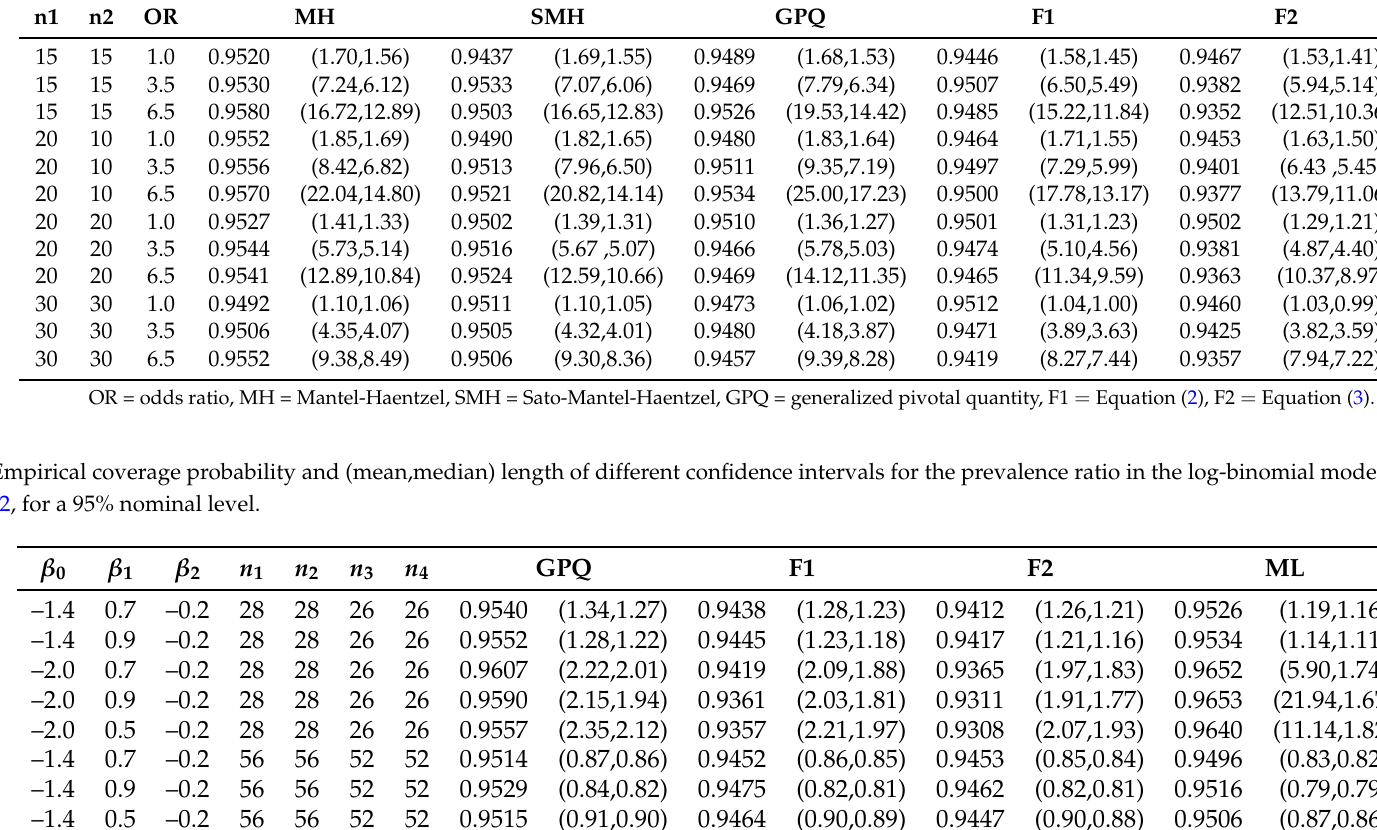
Table 1. Empirical coverage probability and (mean,median) length of different confidence intervals for the common odds ratio for five studies, for a 95% nominal level.